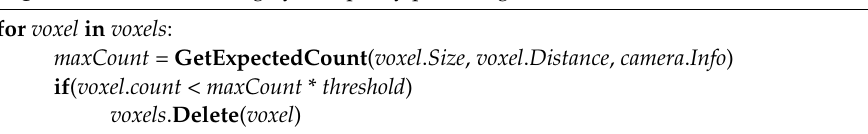
Algorithm 7 Voxel filtering by occupancy